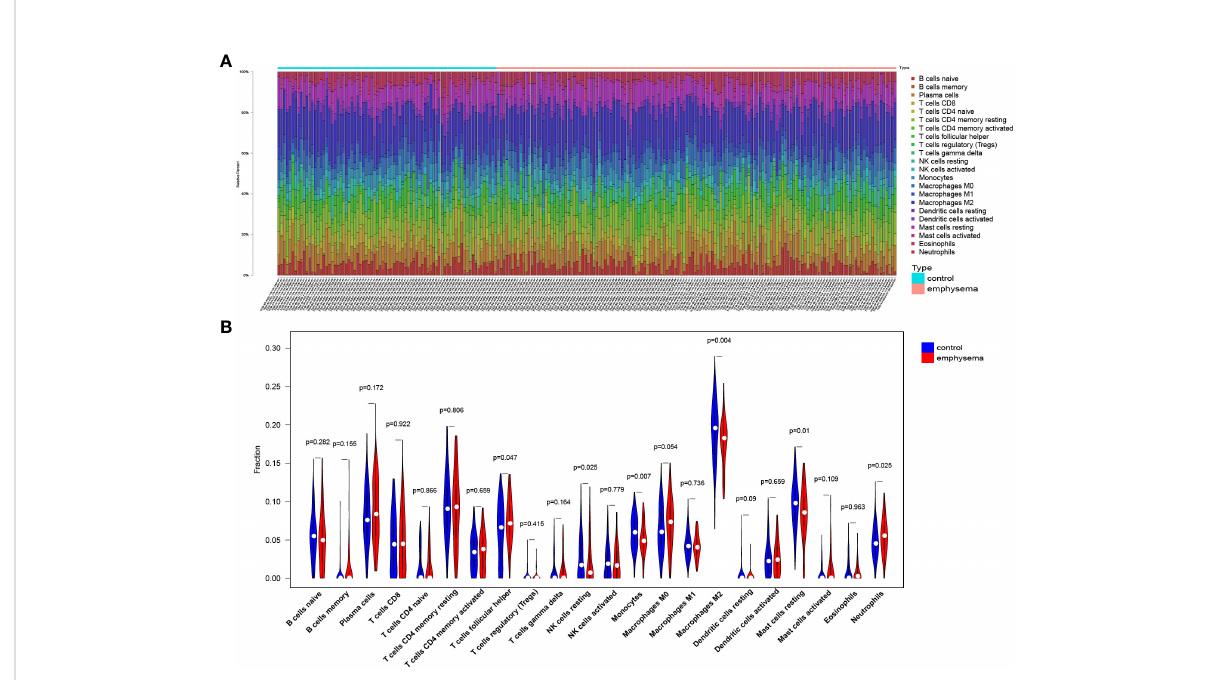
FIGURE 1 The landscape of lung tissue-in fi ltrating immune cells. Bar plot (A) and violin plot (B) shows the distribution of 22 types of immune cells in emphysema phenotype patients and non-emphysema phenotype patients with